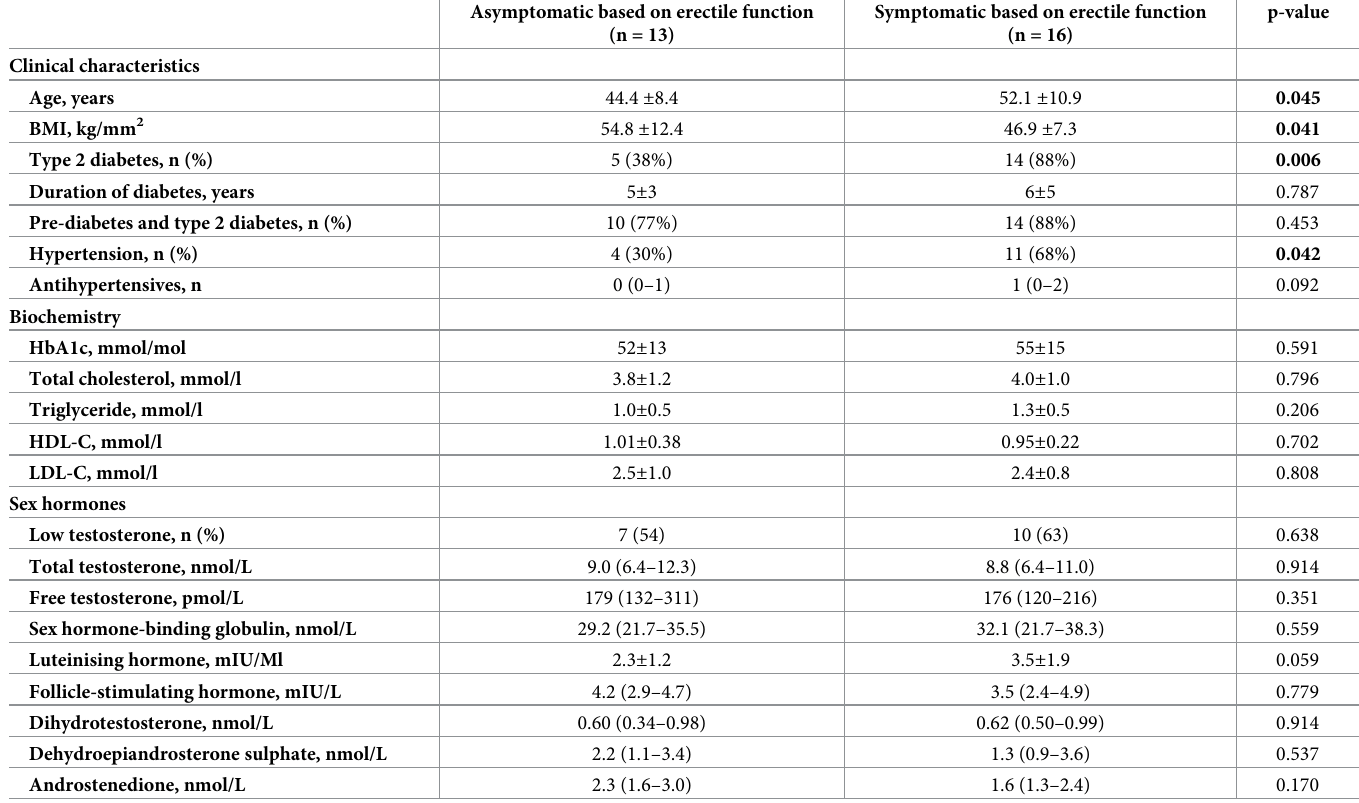
Table 1. Comparison of demographics, clinical characteristics, and sex hormone levels between asymptomatic and symptomatic patients divided based on erectile